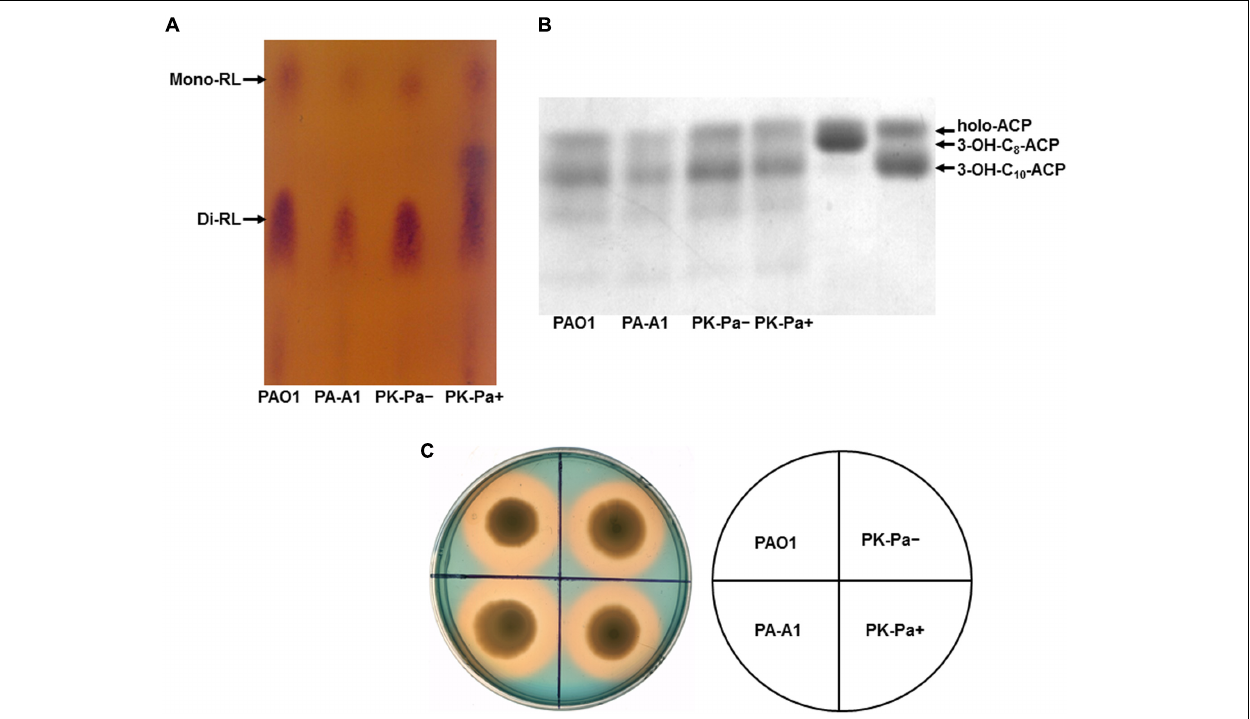
FIGURE 4 | Characterization of rhamnolipid production and siderophore secretion by P. aeruginosa acpP1 mutant strains. (A) Analysis of rhamnolipids produced by acpP1 mutant strains using thin-layer chromatography (TLC). (B) Composition of 3-hydroxyacids in rhamnolipids produced by acpP1 mutant strains. (C) Siderophore secretion in P. aeruginosa acpP1 mutant strains. PAO1, P. aeruginosa wild type strain; PA-A1, P. aeruginosa acp1 ::Ec acpP single mutant strain; PK-Pa − , P. aeruginosa acp1 ::Ec acpP single mutant strain carrying plasmid, pSRKPa, encoding wild type P. aeruginosa acpP1 gene under no IPTG induction; PK-Pa + , complementary strain PK-Pa under IPTG